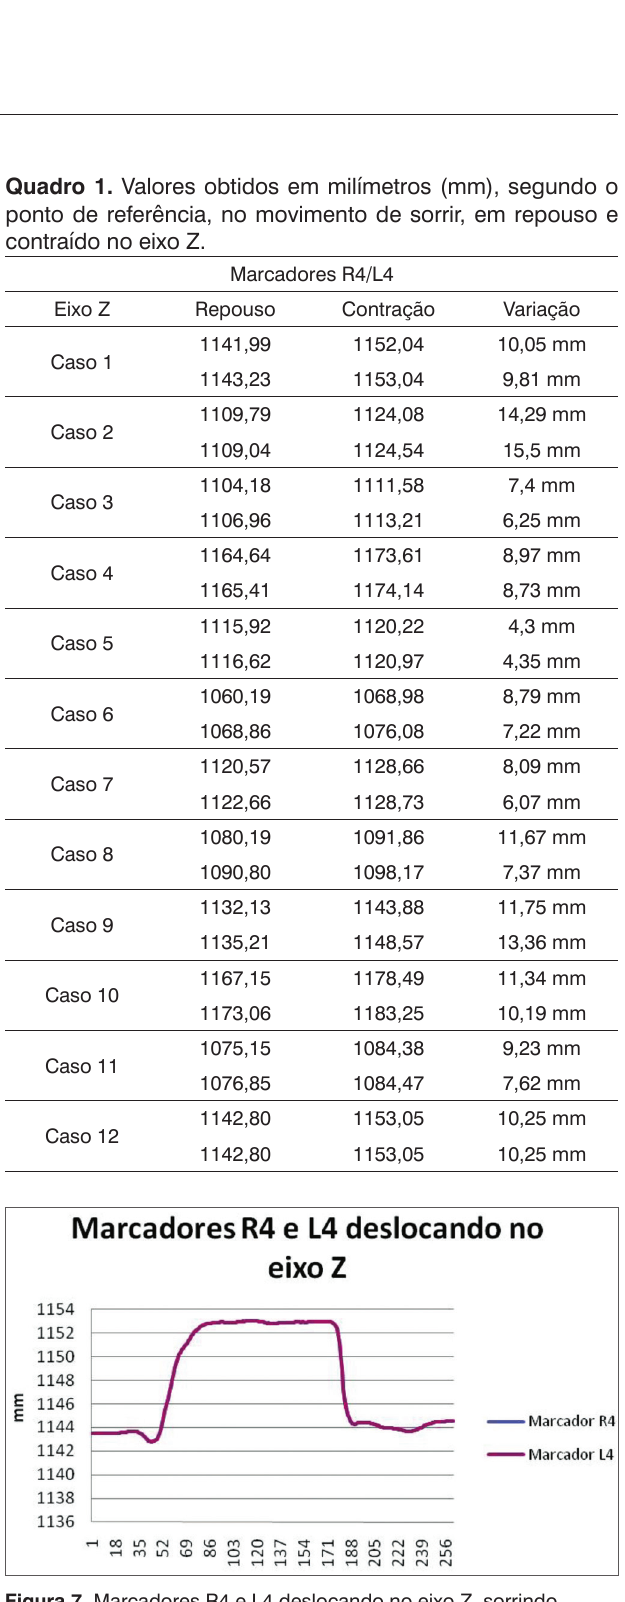
Figura 7. Marcadores R4 e L4 deslocando no eixo Z,